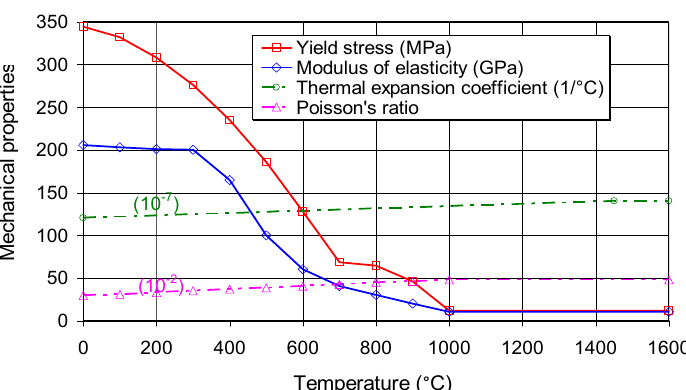
Figure 2. S355J2+N steel, thermal properties [40].